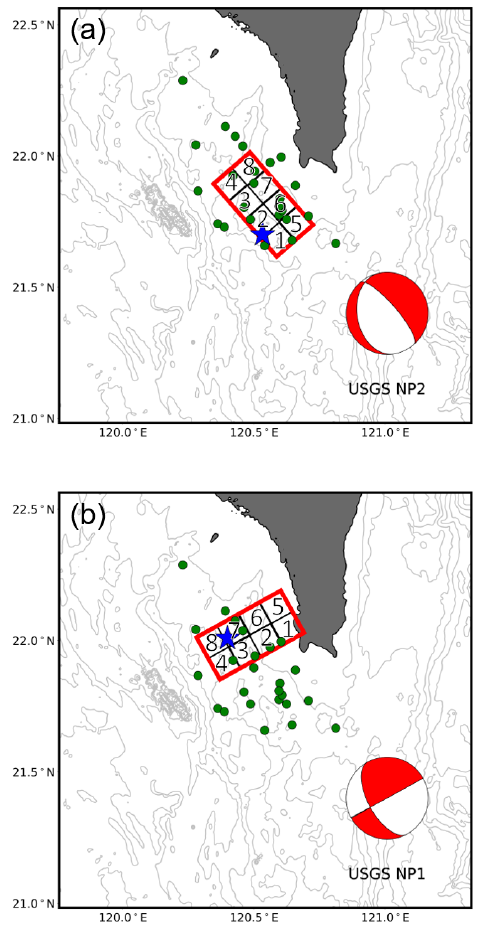
Figure 4. Fault models for the two earthquakes. (a) Subfault loca- tions of the first earthquake ( M w 7.0) using NP2 of USGS’s mo- ment tensor solution. (b) Subfault locations of the second earth- quake ( M w 6.9) using NP1 of USGS’s moment tensor